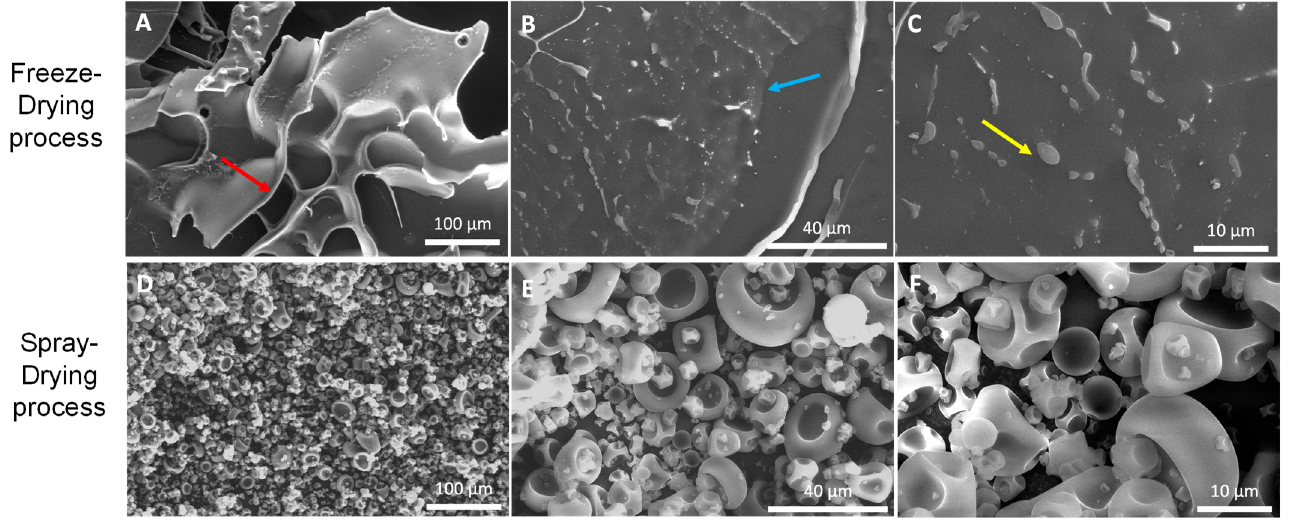
Figure 1. SEM images of β -glucan powder microencapsulated by: FD ( A – C ); and SD ( D – F ); methods using MD as wall material. The following magnification was applied: ( A , D )—250×; ( B , E )—1000×; ( C , F )—2500×.